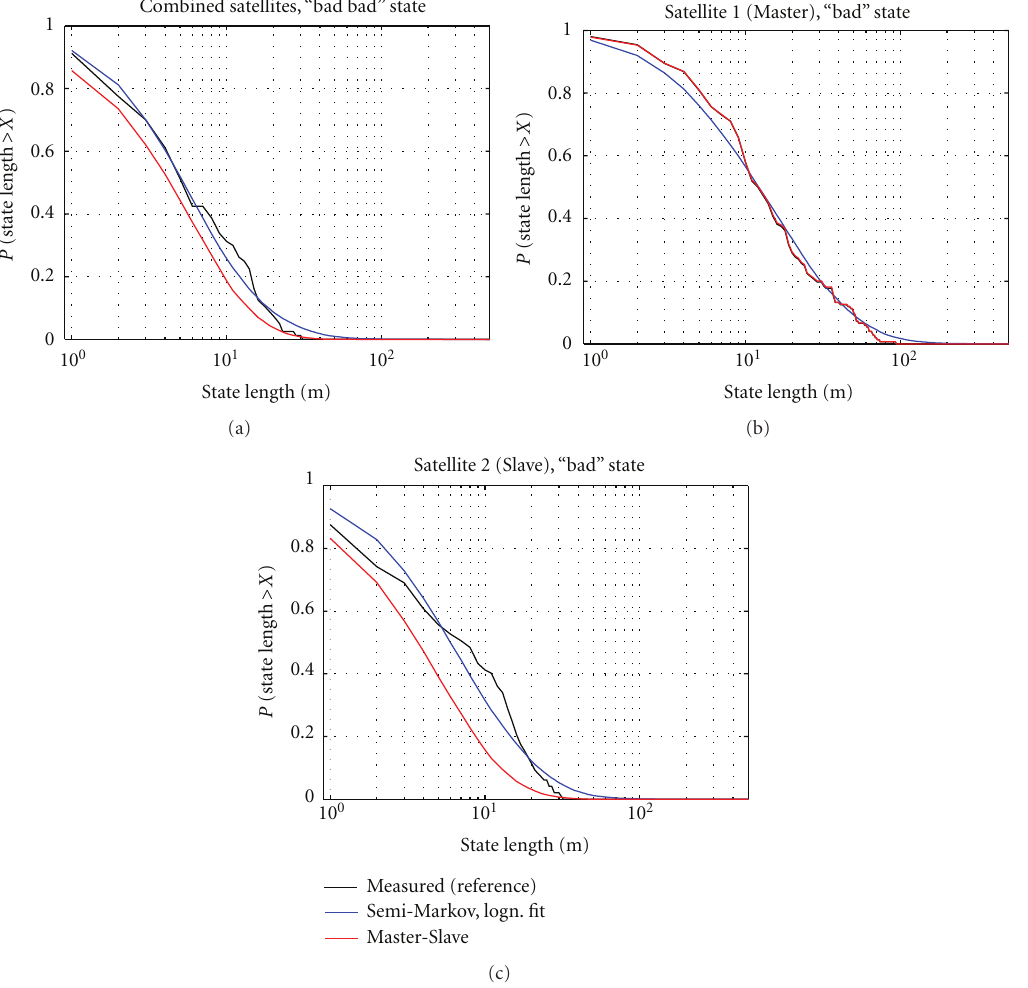
Figure 20: State duration statistics of the combined “bad bad” state (a) and single satellite “bad” states (b and c) derived from the measurements and resimulated with two modelling approaches. The 4-state semi-Markov approach resimulates accurately the state duration statistics. The Master-Slave approach with the “Conditional Assembling Method” resimulates accurately the state durations of the Master satellite but has limitations in duration modelling of the joint states and the slave